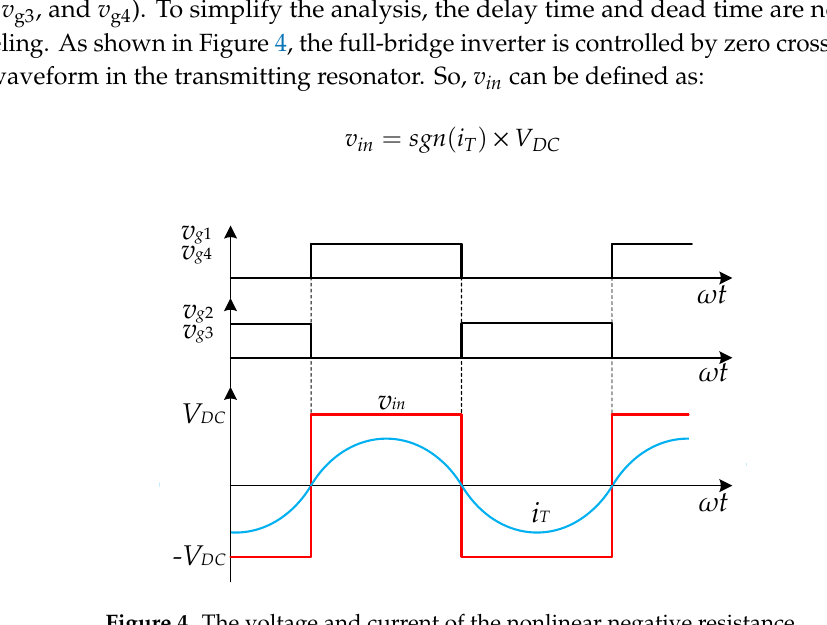
Figure 4. The voltage and current of the nonlinear negative resistance.